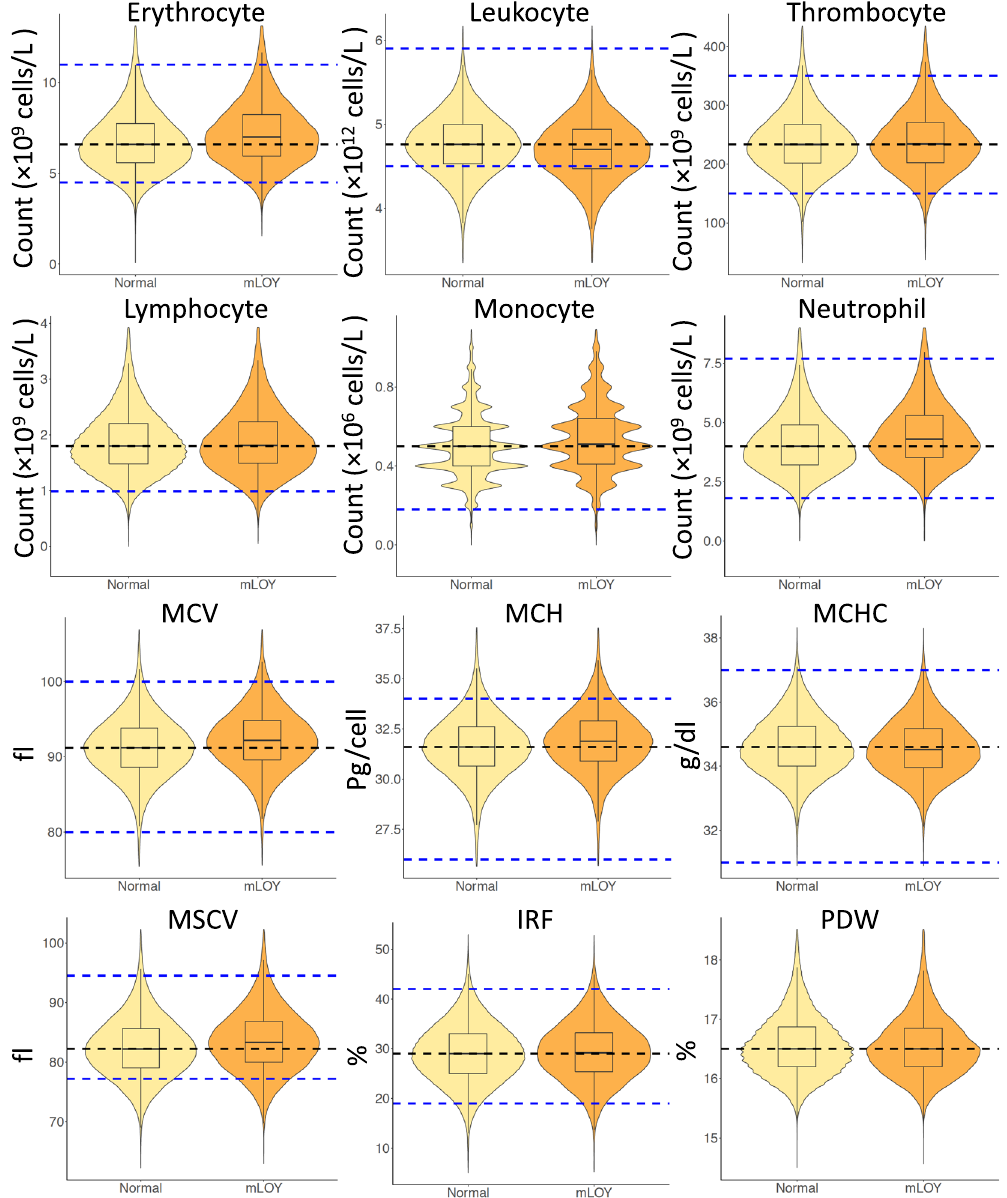
Figure 2. Blood cell counts and indices by mLOY status. Various blood cell counts among men with different mLOY status were observed in univariate analyses. Yellow, Normal: men with normal chromosome Y; Orange, mLOY: men with mLOY. All displayed counts and indices had p < 0.001 when comparing between participants with or without mLOY. Black dashed lines: median count among normal individuals. Blue dashed lines: reference ranges from prior studies 73–75 . MCV: mean corpuscular volume. MCH: mean corpuscular hemoglobin. MCHC: mean corpuscular hemoglobin concentration. MSCV: mean sphered corpuscular volume. IRF: immature reticulocyte fraction. PDW: platelet distribution